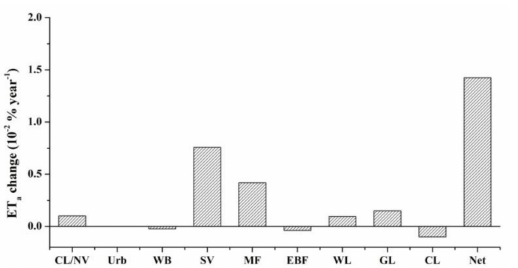
Figure 10. Effects of land-use changes on the ET a trend (Net: total effect of all the land-use